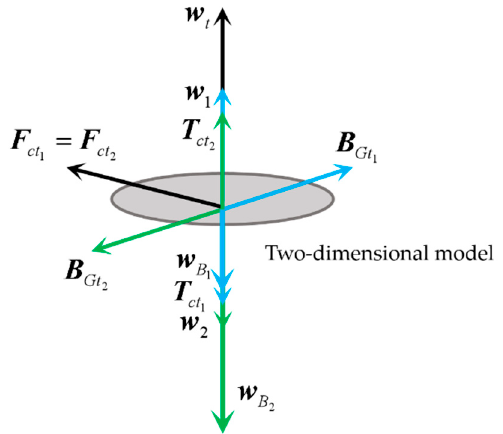
Figure 11. Diagram of inverse solution result.